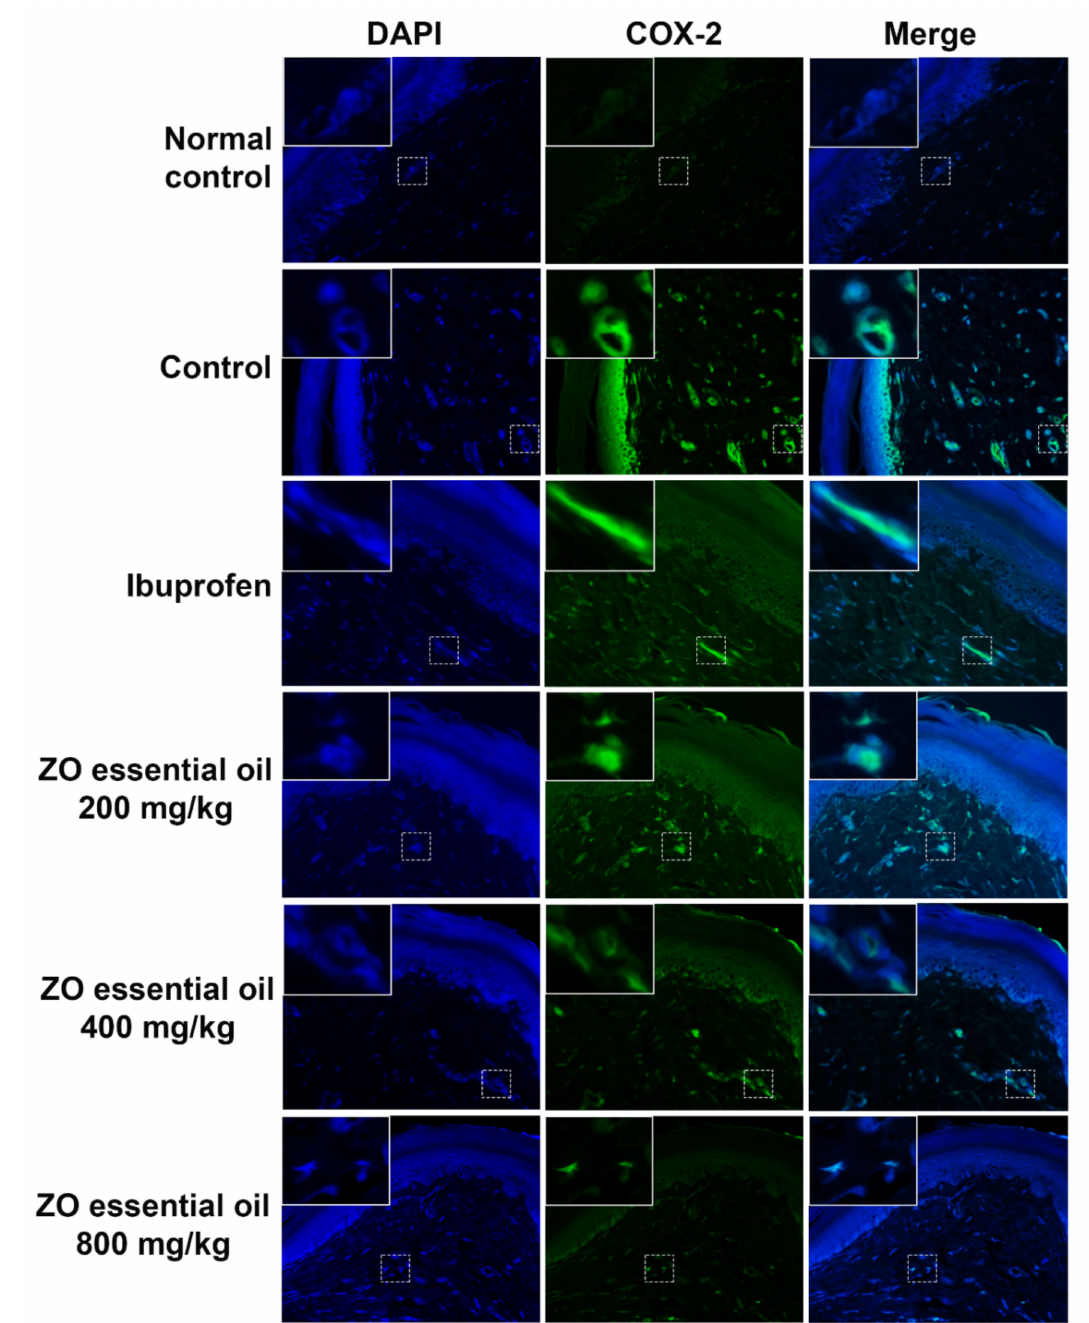
Figure 5. Immunofluorescence study for COX-2 expression in paw tissue of rats, pretreated with vehi- cle (0.9% saline), ibuprofen (100 mg/kg), or ZO essential oil at different doses, at 6 h after carrageenan injection. Micrographs were photographed by a fluorescence microscope (400 ×